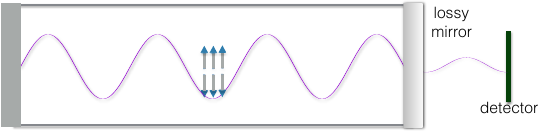
Figure 1: Proposed setup. Spins are initialized in a direct product state and placed inside a cavity with a lossy mirror. The number of photons emitted is measured at the output of the lossy